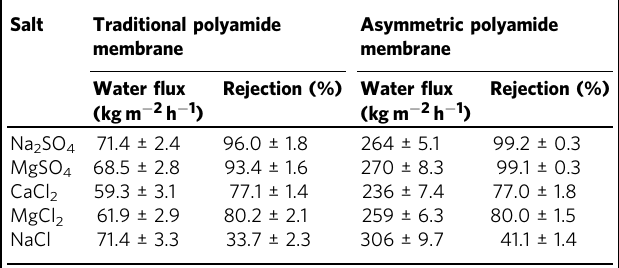
Asymmetric polyamide